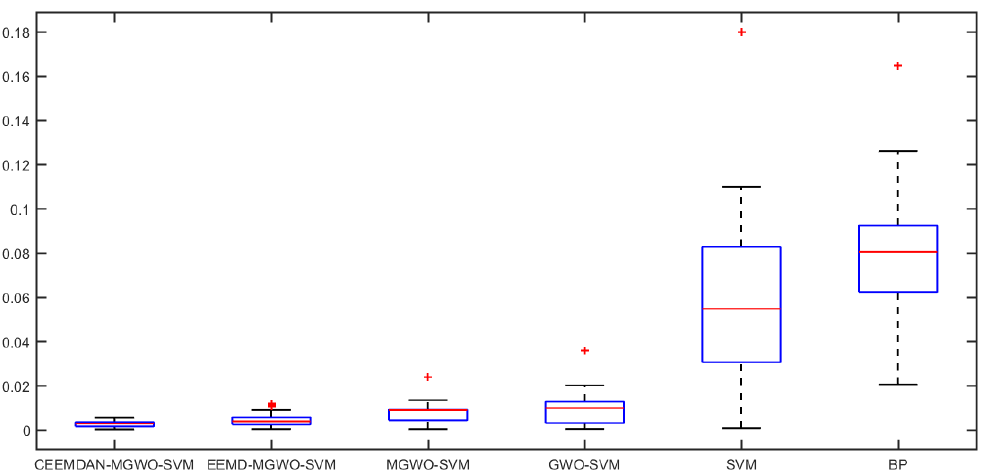
Figure 12. The boxplot of relative errors for different models. As shown in Figure 12, the relative error of the CEEMDAN-MGWO-SVM model forecasting result is the smallest, followed by EEMD-MGWO-SVM model, and the relative error of BP neural network forecasting result is the largest. The relative errors of the forecasting results for different models are shown in Table 6. Table 6. The relative errors of the forecasting results for different